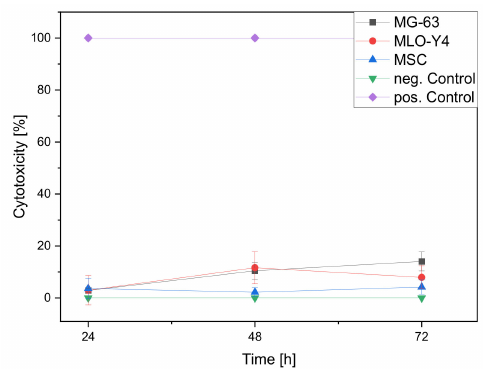
Figure 6. Cytotoxicity of the collagen-coated PCL scaffolds at defined times for the 3 different cell lines; neg. control = cells only; pos. control = Triton